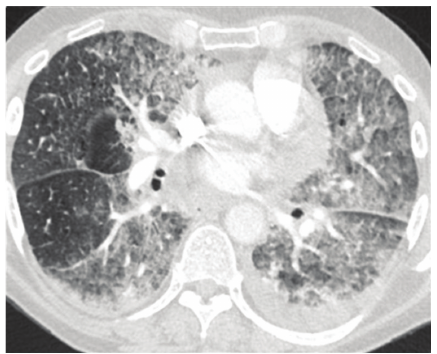
Figure 1: Computed tomography of the chest illustrating severe bilateral opacities with ground-glass appearance.